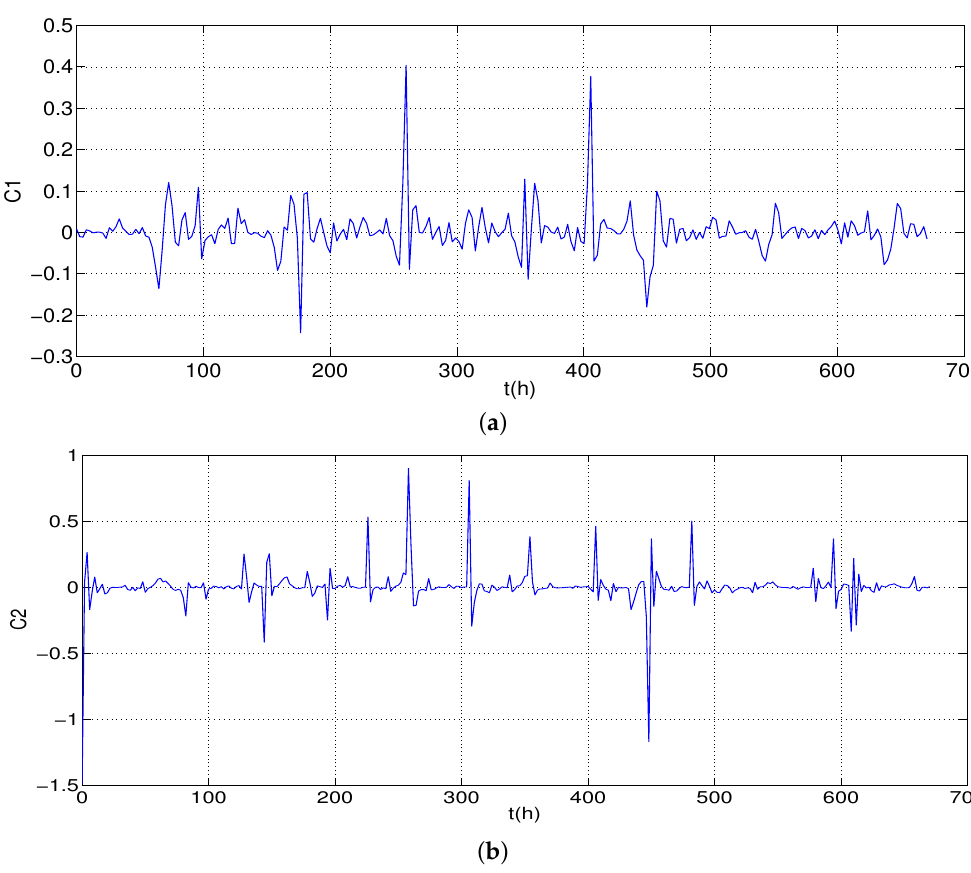
Figure 9. Evolution of the degree of freedom C . ( a ) Evolution of C 1 , ( b ) Evolution of C 2 .